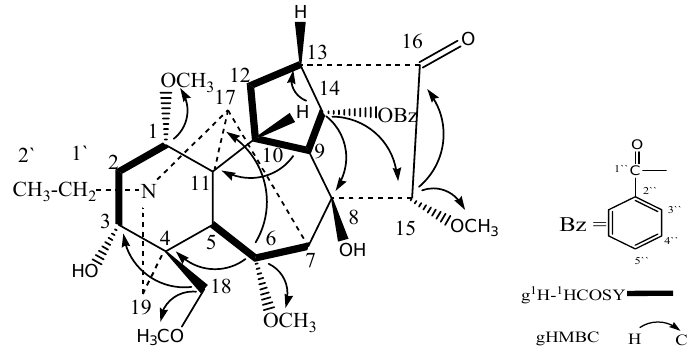
Figure 1. Structure and Key Correlations of Compound 1